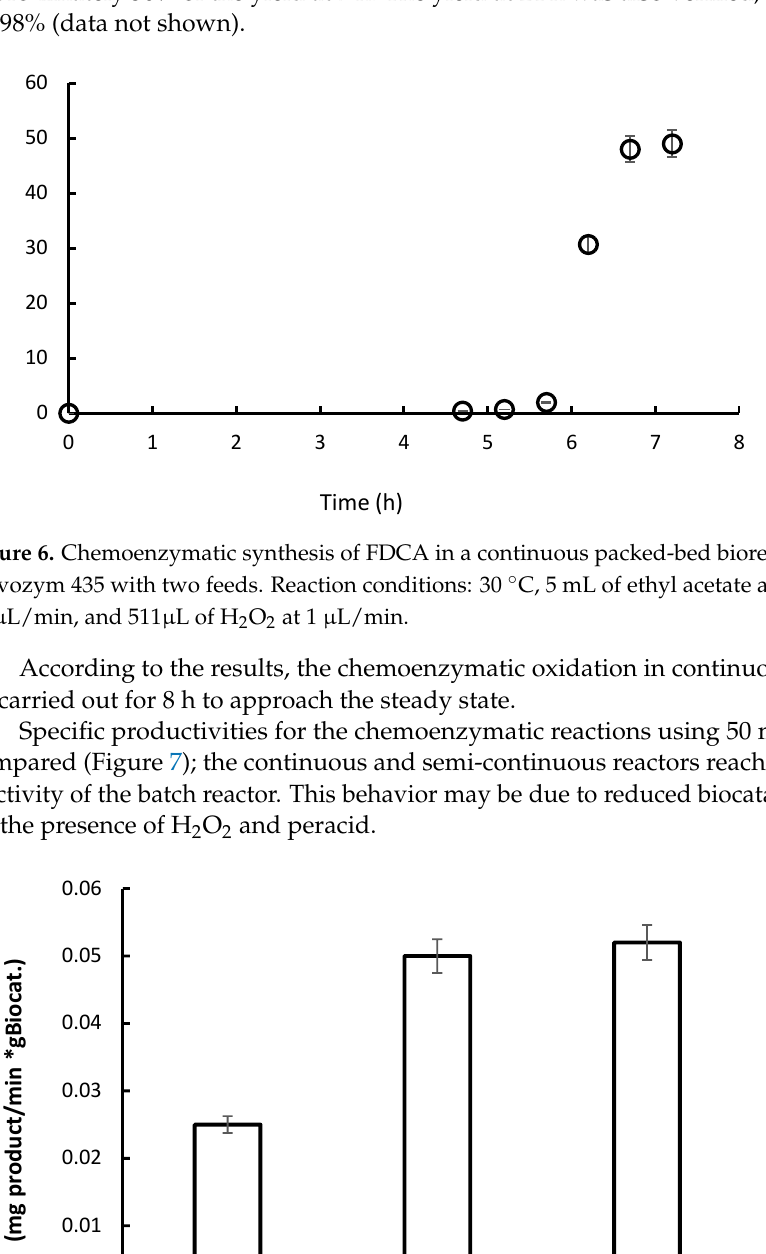
Figure 7. Comparison of productivities of chemoenzymatic oxidation to produce FDCA in different reactors, using a substrate concentration of 50 mM of DFF, 40 °C, 500 mg of biocatalyst, and 1021 µL of H 2 O 2 .